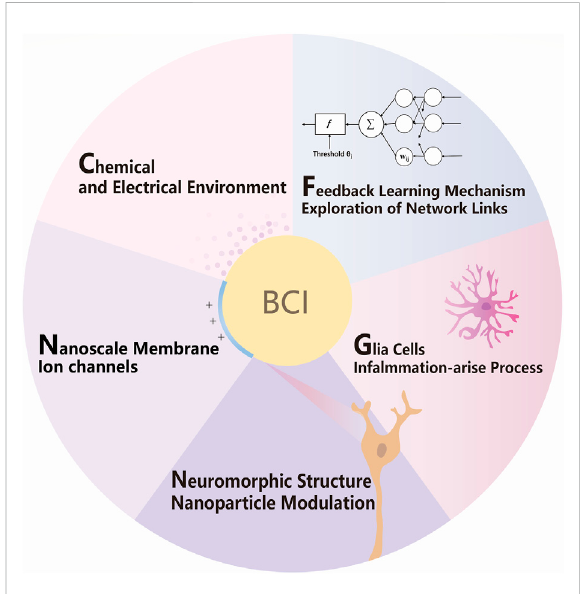
FIGURE 1 Schematic of strategies for molecular, cellular, and network modulation of